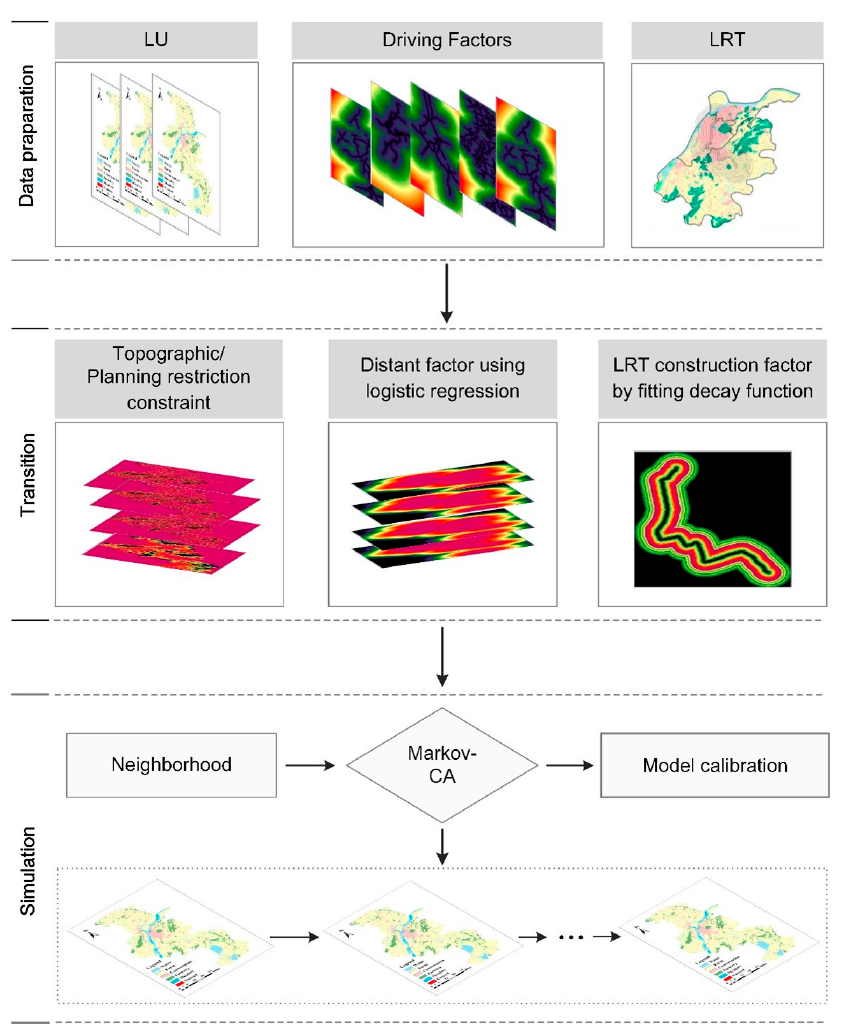
Figure 3. Workflow for evaluation of the spatiotemporal heterogeneity impact of LRT on LU change.